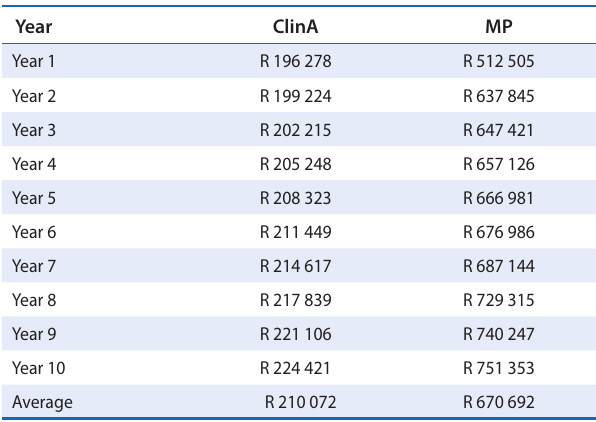
Table 2: Calculation of average salary over 10 years for Clinical Associates compared with Medical